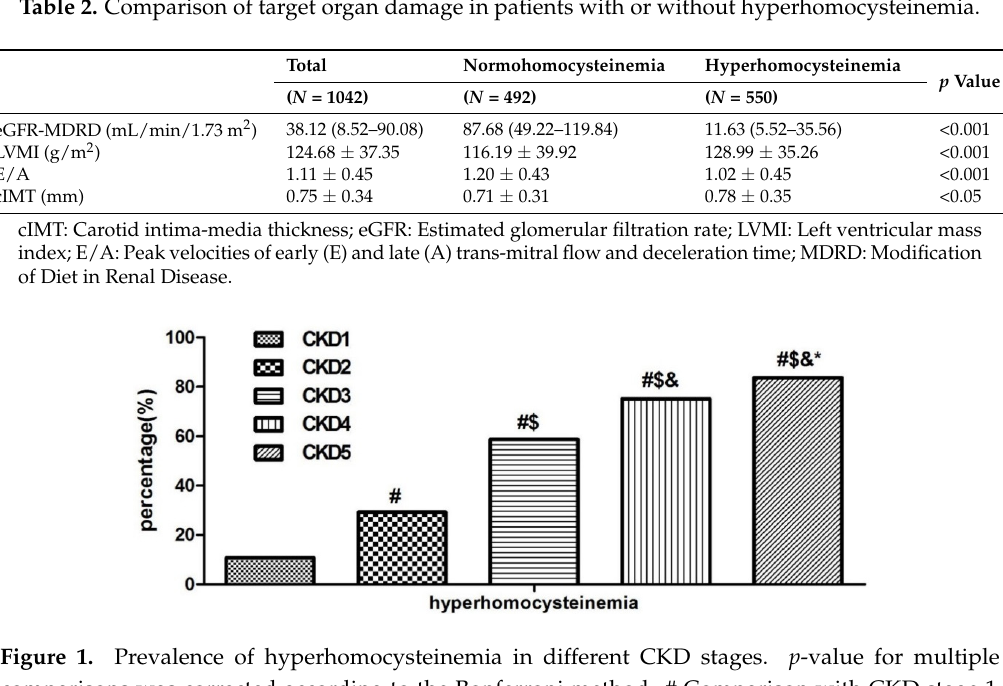
Figure 1. Prevalence of hyperhomocysteinemia in different CKD stages. p ‐ value for multiple comparisons was corrected according to the Bonferroni method. # Comparison with CKD stage 1, p < 0.05; $ comparison with CKD stage 2, p < 0.05; & comparison with CKD stage 3, p < 0.05; * comparison with CKD stage 4, p < 0.05).